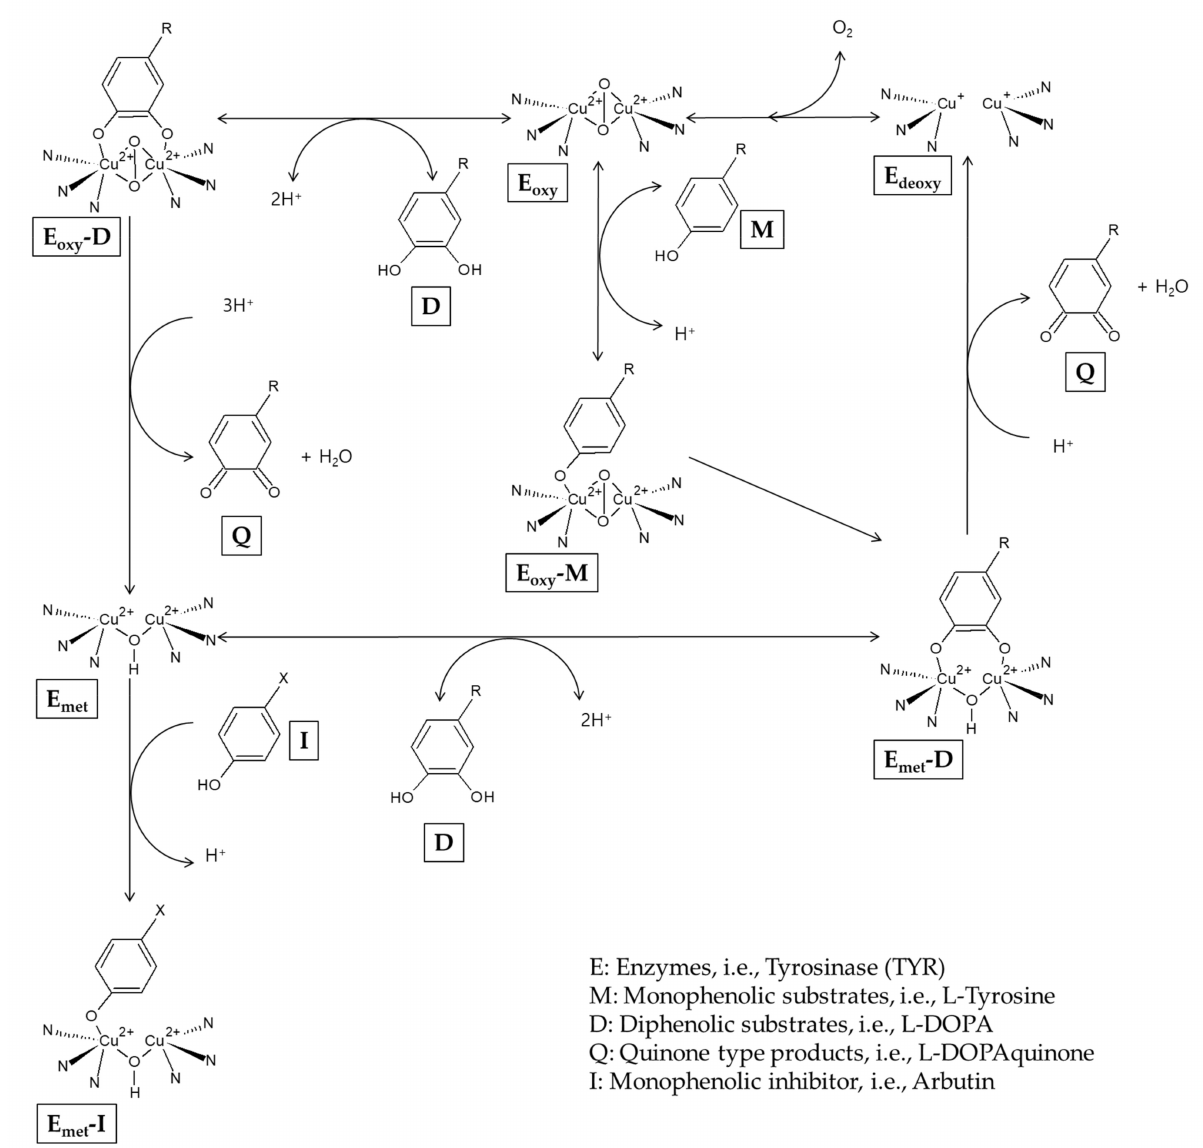
Figure 2. A potential mechanism for the inactivation of tyrosinase by